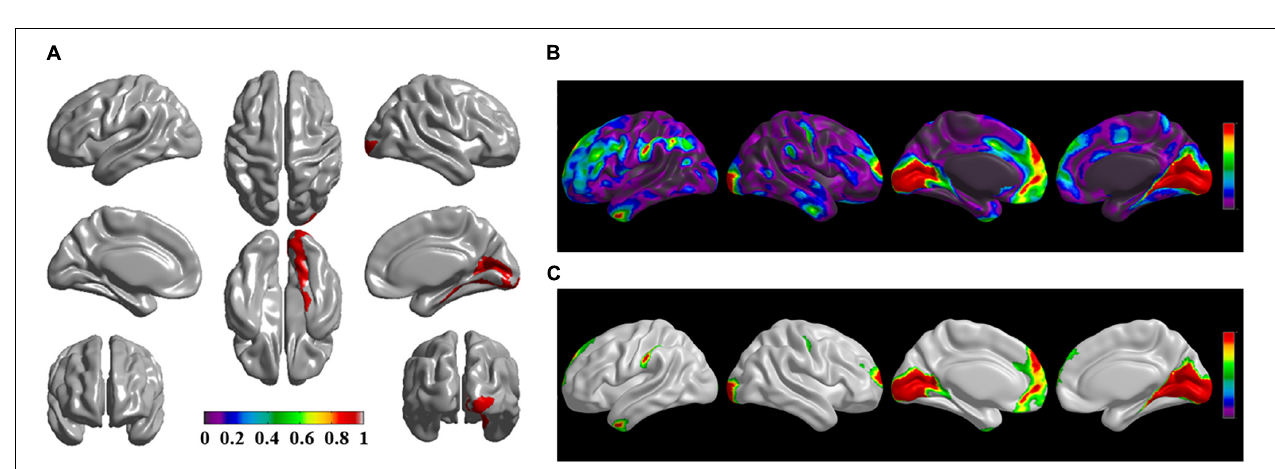
FIGURE 1 | The significantly altered brain regions of cortical structural connectivity in the sPD brain based on seed 1. (A) The brain regions of seed 1, the red brain regions represent the cortical thickness thinning regions. (B) The significantly altered brain regions in the F-map based on seed 1, the red, and green brain regions represent the brain regions of significant cortical structural connectivity alteration that were not corrected by the family-wise error (FWE). (C) The significantly altered brain regions after FWE correction based on seed 1, the red and green brain regions represent the brain regions of significant cortical structural connectivity alteration that were corrected by the FWE.